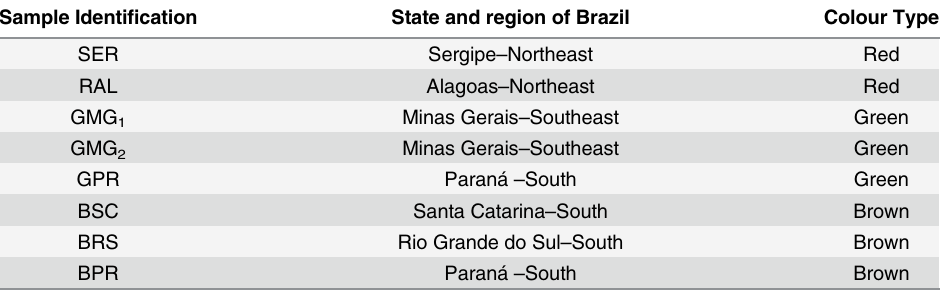
Table 1. Identification of propolis samples from different regions of Brazil and analysed in this study. Sample Identi fi